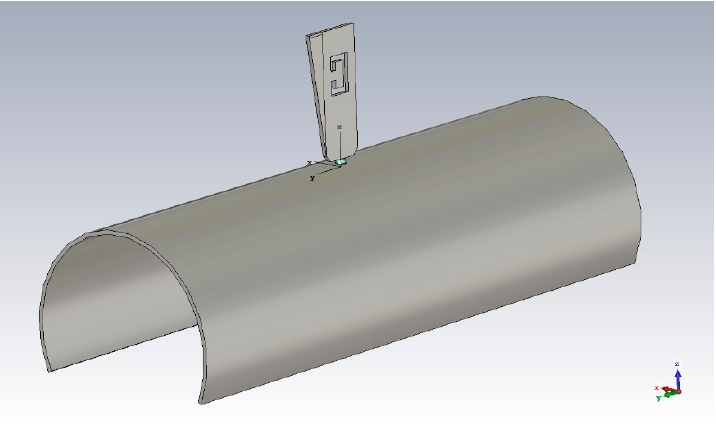
Figure 6. Bent ground plane, ‘X’ direction (R = 50 mm, example)—perspective view.